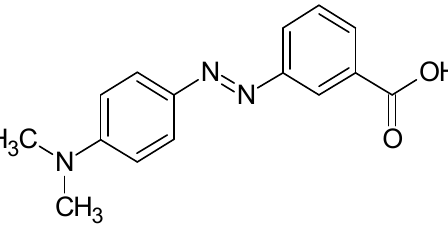
Figure 1. Structural formula of MR dye.